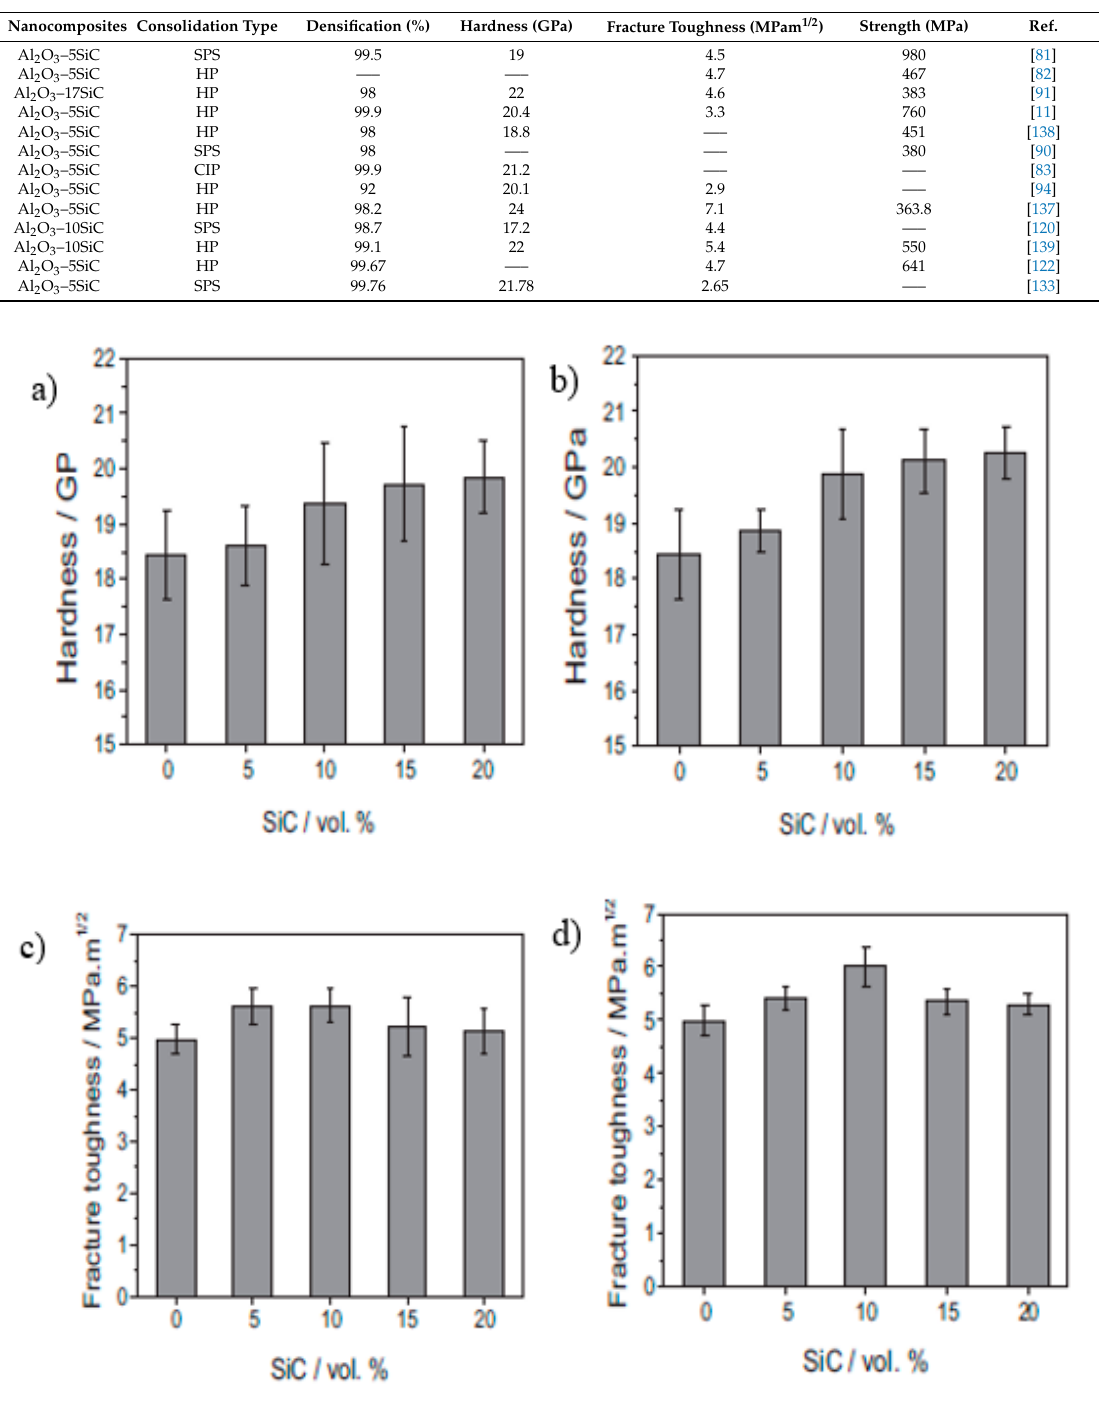
Figure 2. Mechanical properties of alumina–SiC nanocomposites: ( a , b ) hardness; ( c , d ) fracture toughness. Reproduced with permission from [10]. Copyright Elsevier, 2014. Table 1. Mechanical properties of Al 2 O 3 –SiC nanocomposites.